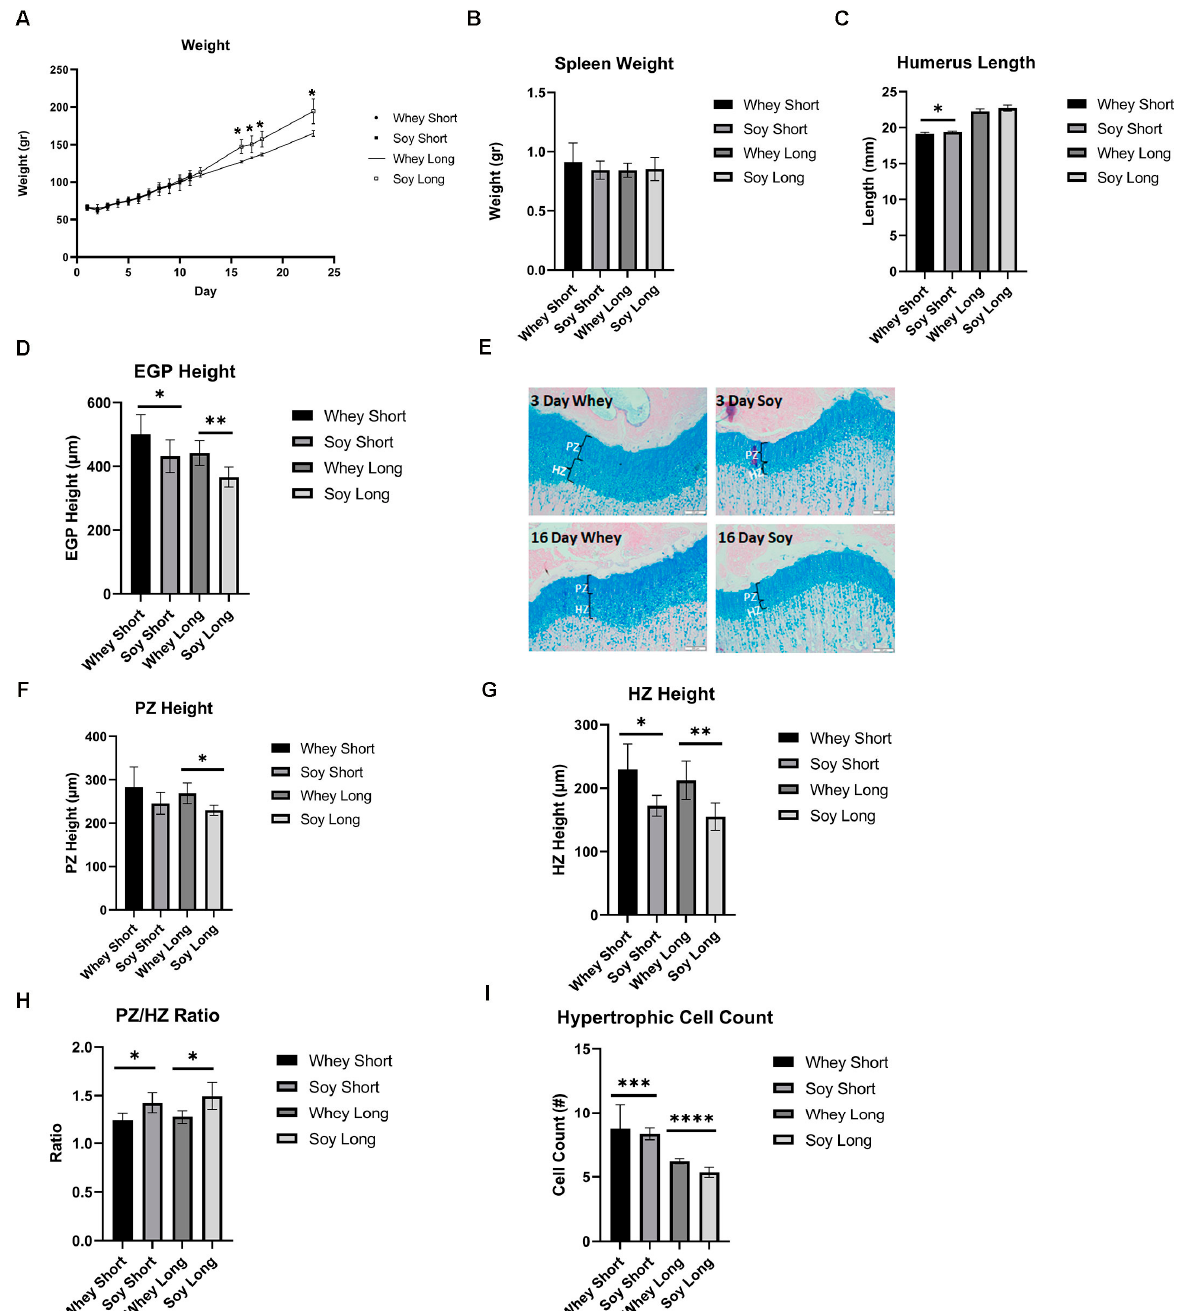
Figure 5. The effect of recovery from LPS-induced inflammation using study diets on ( A ) weight, ( B ) spleen weight, ( C ) humerus length, ( D ) EGP height, ( E ) representative stained sections of EGP from all groups, ( F ) PZ height, ( G ) HZ height, ( H ) PZ/HZ ratio, ( I ) hypertrophic cell count. Student’s t -test was used (the two time points were compared per each group). ( A – I ) Mean ± SD values are shown (n = 5/6 per group). * <0.05; ** <0.01; *** <0.001; **** <0.0001.